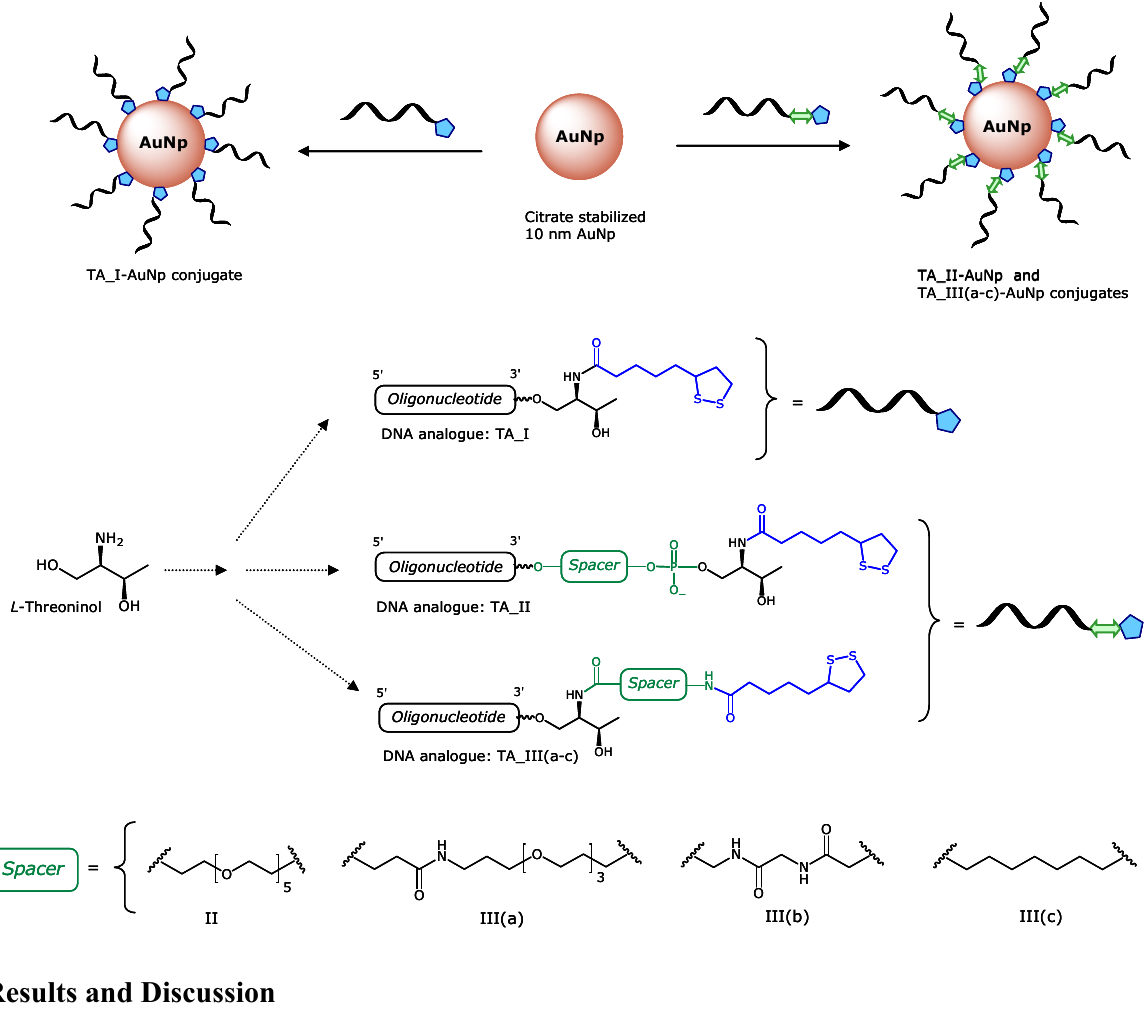
Figure 1. Preparation of gold nanoparticles functionalized with TA-terminated